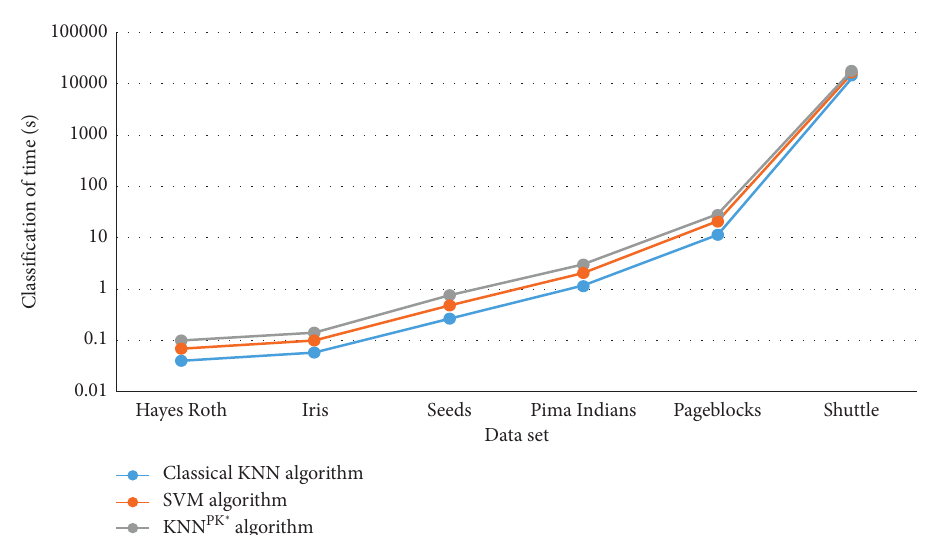
Figure 13: Comparison of the classification time log coordinates of three